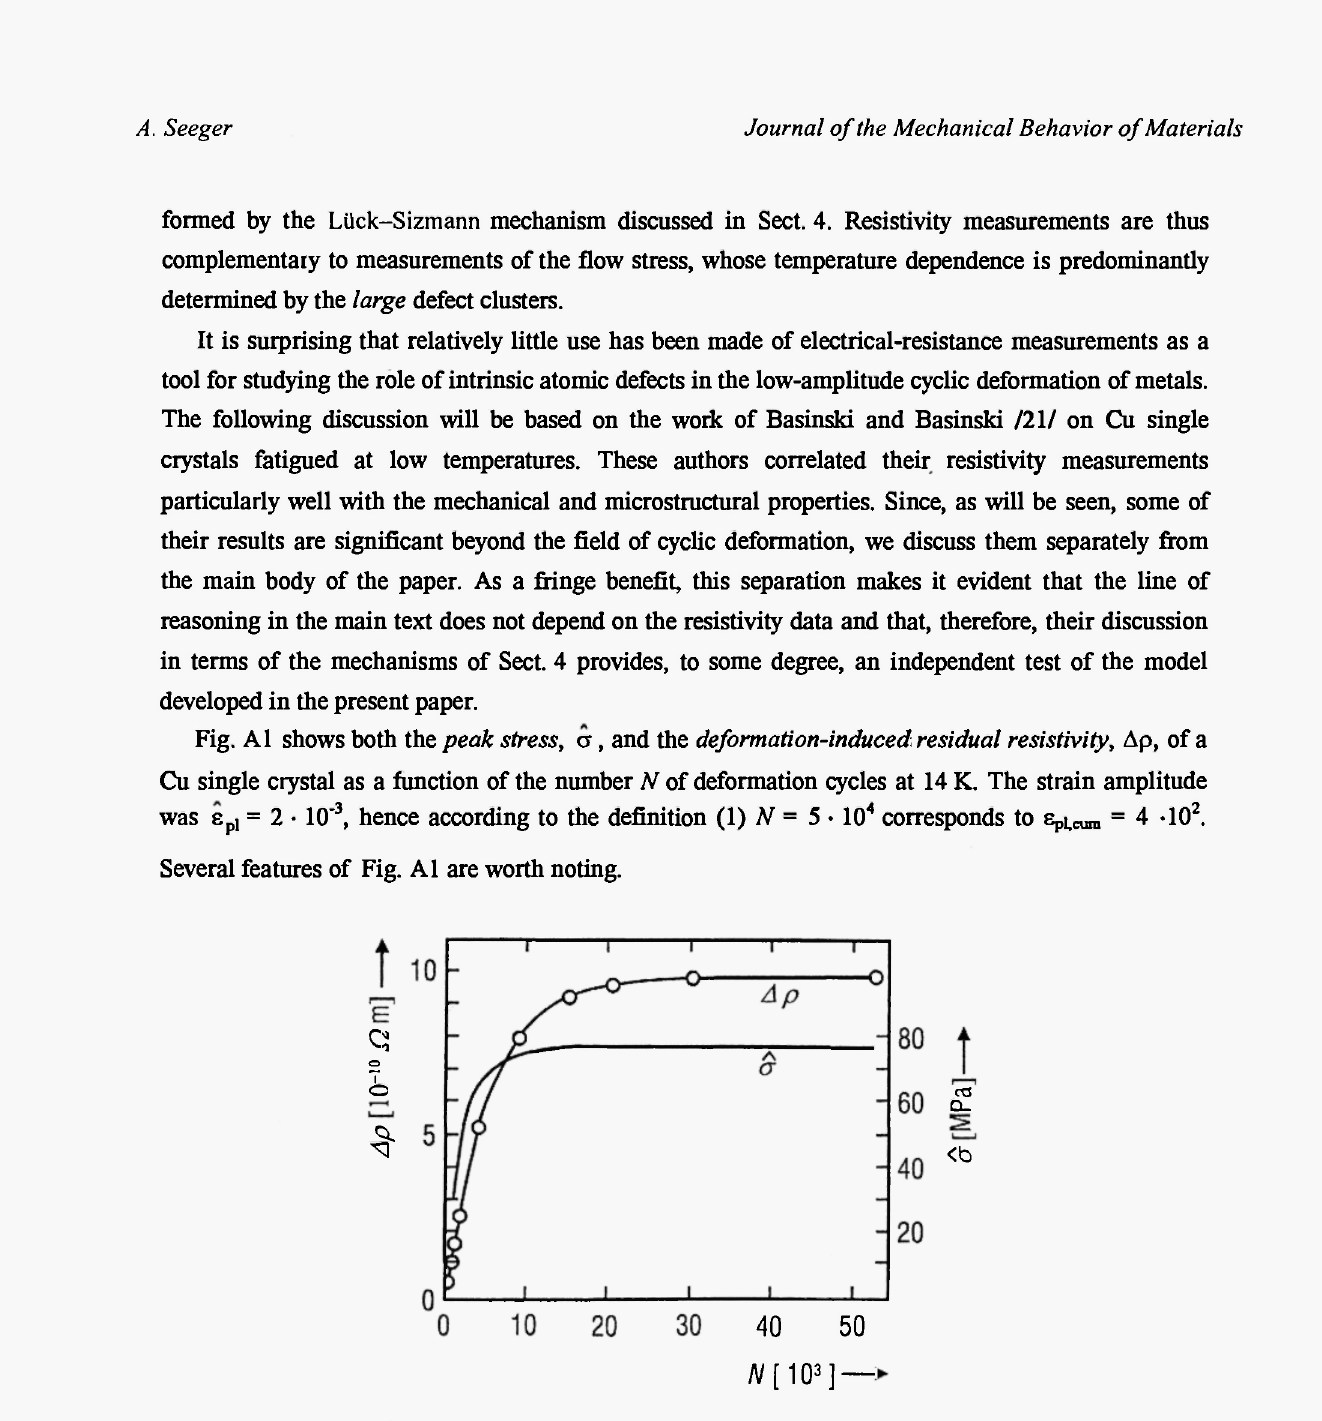
Fig. Al: Peak stress, σ, and change of the residual electrical resistivity, Δρ, of a Cu single crystal fatigued at 14 Κ at ε ρ1 = 2·10~ 3 as functions of the number of cycles, Ν /21/. From σ (AO the cyclic-hardening curve σ= σ(£· ρ) c u m ) is obtained by making use of ε ρ] cum = 4jVe pl .